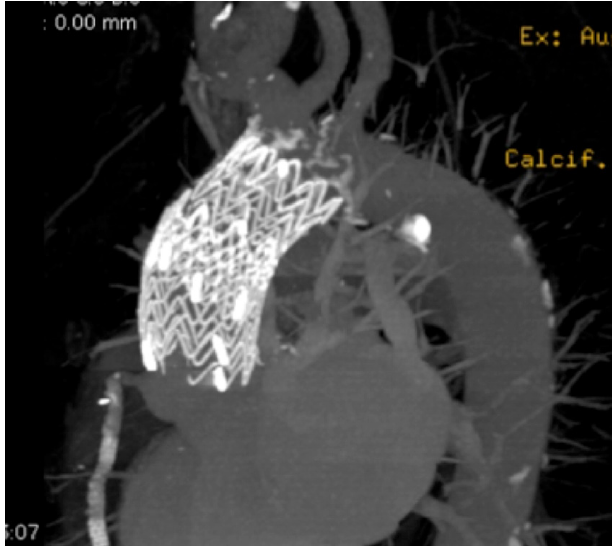
Fig. 6 – Use of two stent grafts for correction of ascending aorta pseudoaneurysm and coronary stent on right coronary